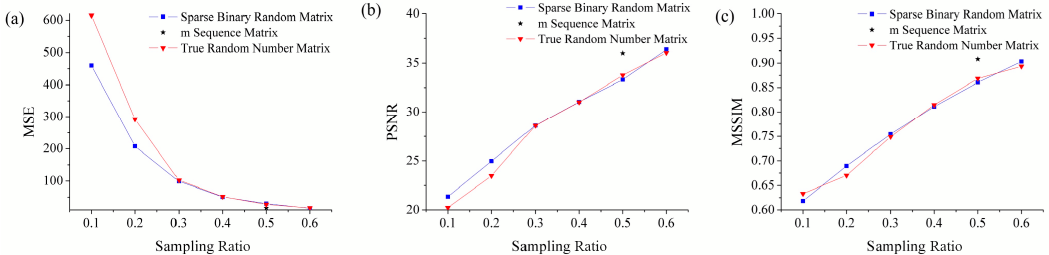
Figure 5. The corresponding curves of evaluation indices with the changing compressive sampling ratio. ( a ) The MSE of reconstructed image with the changing compressive sampling ratio. ( b ) The PSNR of reconstructed image with the changing compressive sampling ratio. ( c ) The MSSIM of reconstructed image with the changing compressive sampling ratio.